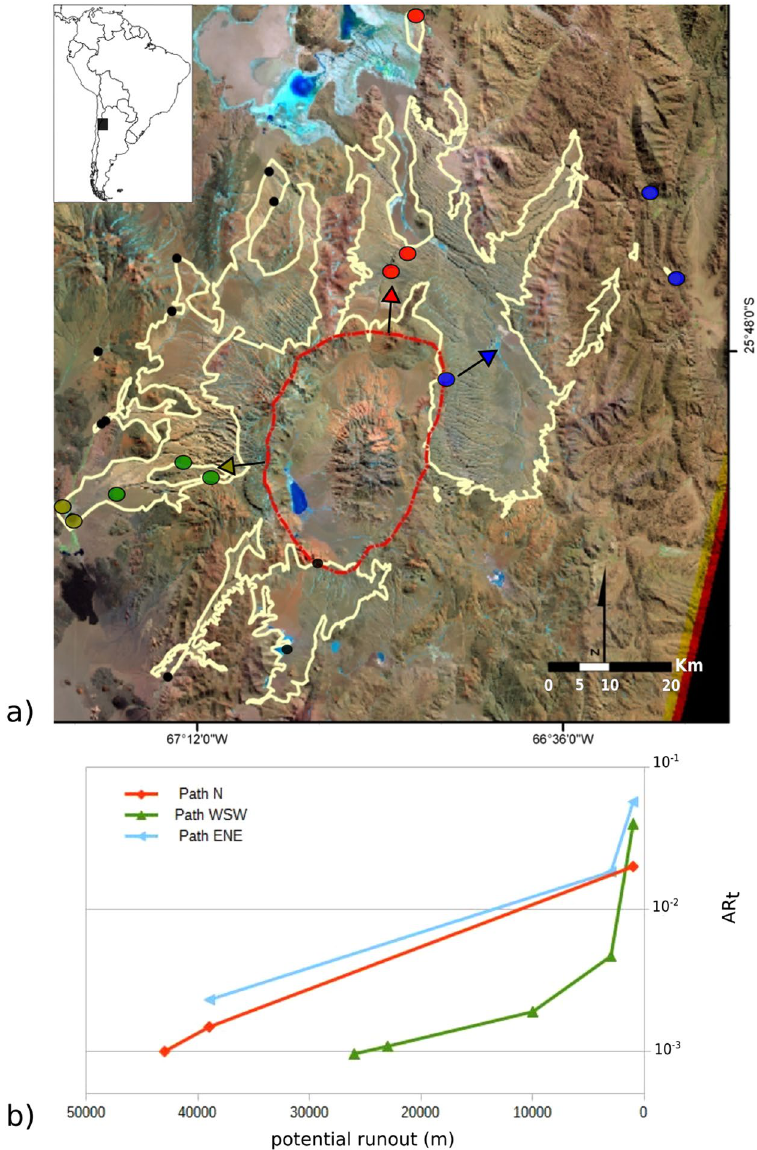
Figure 2. Topological aspect ratio (AR t ) of the Cerro Galan Ignimbrite (Argentina; see Table S1 in Suppl. Material for characteristics); ( a ) Areal extent of the ignimbrite (yellow line); topographic rim of caldera in dashed red; green, red and blue dots indicate sites with measured sections used for calculation of AR t along paths indicated by arrows (see Table S2 Supplementary Material; data from 9, 26 ) – ( b ) Plot of potential runout versus topological aspect ratio AR t . The continuous rise of AR t with distance indicates persistent forced flow conditions supported by a high mass flux (see text for explanation). (Landsat imagery courtesy of NASA Landsat Program, 2007, Landsat ETM + scene LE72310792006253COA00, SLC-Off, USGS, Cerro Galan, 10/9/2006; inset map of S America is taken from http://www.d-maps.com/pays.php?num_pay = 120&lang = en; drawing realized with Inkskape ver 0.91